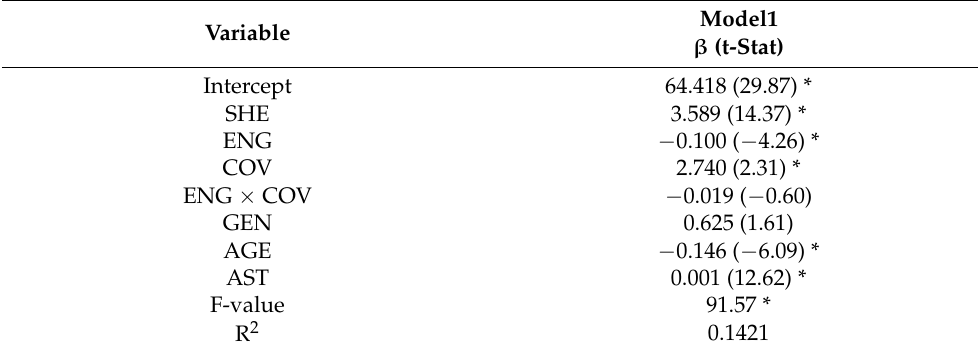
Table 4. Results of hypotheses testing ( n =